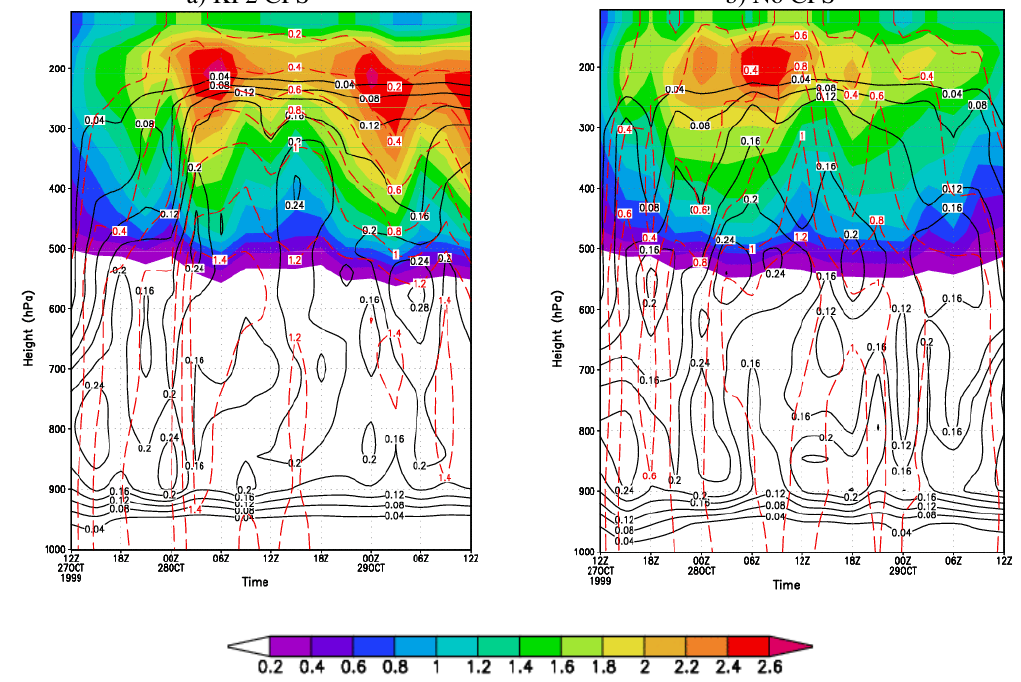
Fig. 9. Time-height cross section of hydrometeors mixing ratio in gmkg − 1 (frozen hydrometeors are shaded, liquid hydrometeors are solid contours for cloud water and dashed contours for rain water), averaged over the square area of 1 ◦ × 1 ◦ , in the storm core with (a) and without CPS (b) in D3.